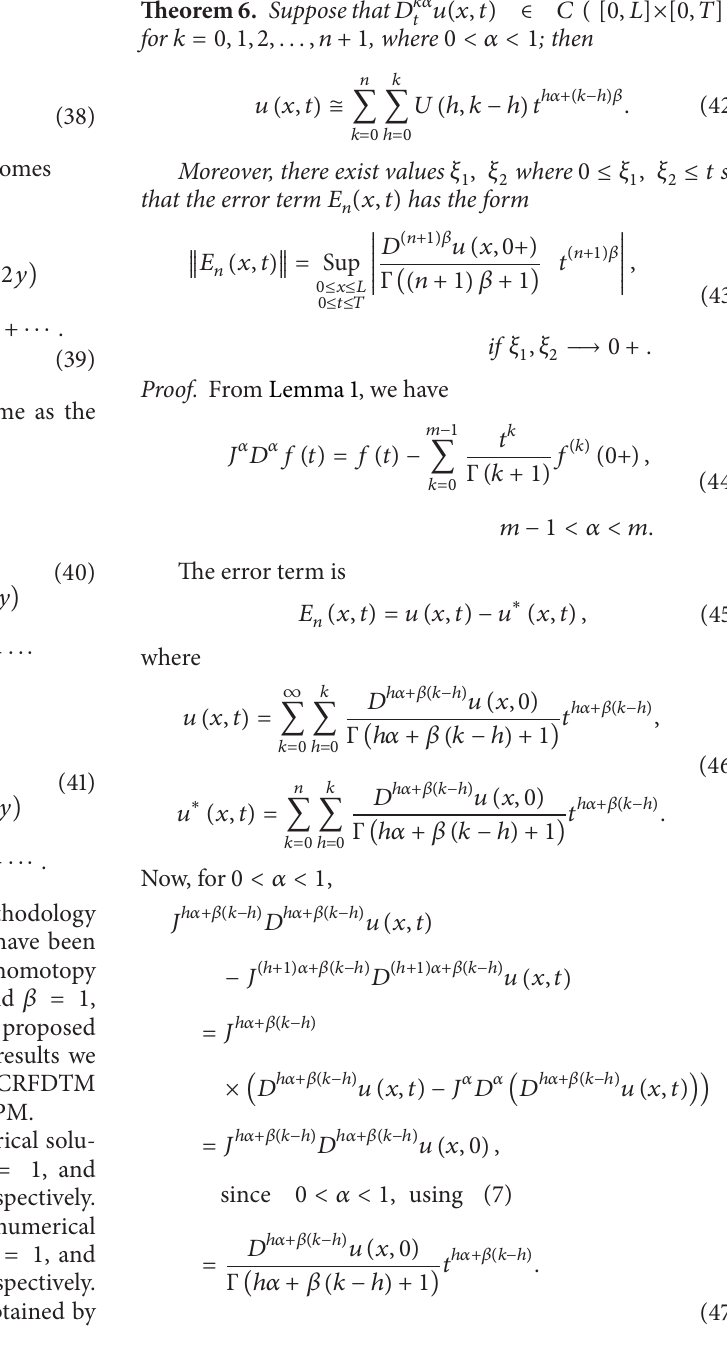
Figure 3 cites the numerical solutions of 𝑢(𝑥, 𝑦, 𝑡) and V (𝑥, 𝑦, 𝑡) for 𝛼 = 1/4 , 𝛽 = 1/2 , and 𝑡 = 0.3 , respectively, and Figure 4 depicts the numerical solutions of 𝑢(𝑥, 𝑦, 𝑡) and V (𝑥, 𝑦, 𝑡) for 𝛼 = 0.88 , 𝛽 = 0.005 , and 𝑡 = 0.1